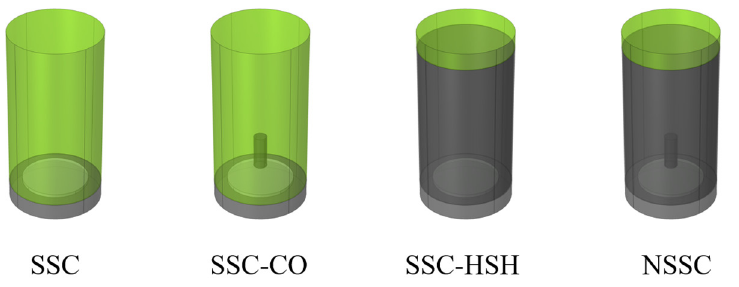
Figure 5. Sound absorption structure with cavities (SSC) and its derivatives (SSC-CO, SSC-HSH, NSSC).